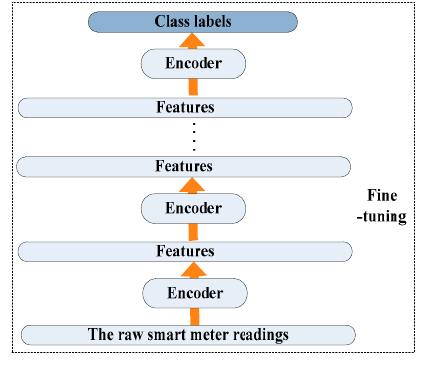
Figure 5. The overall fine-tuning.